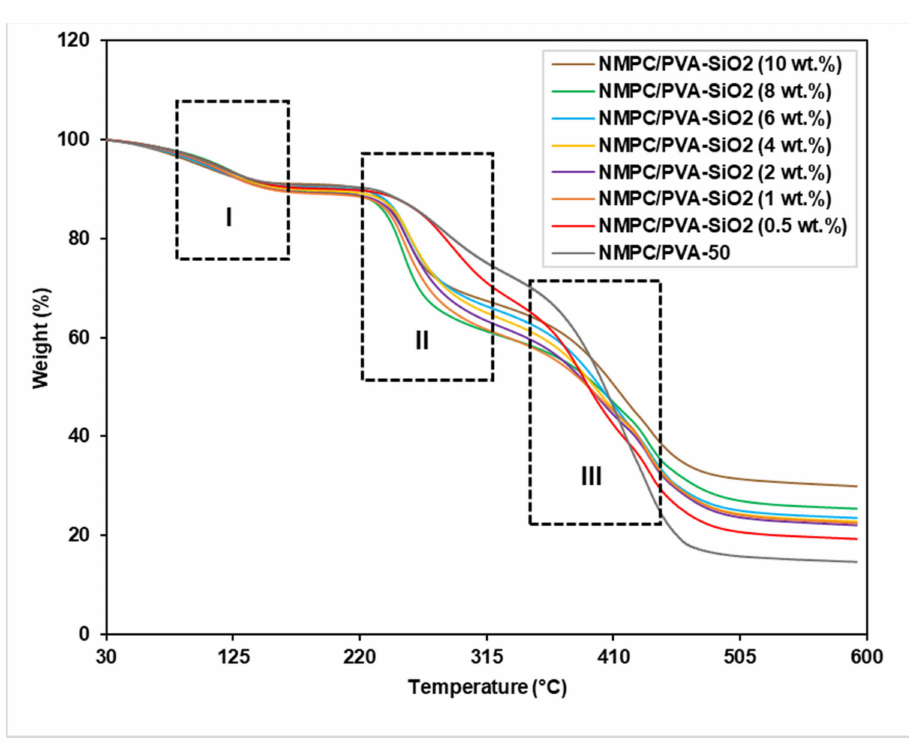
Figure 9. TGA curves of the NMPC/PVA-50 composite membrane and NMPC/PVA-SiO 2 composite membranes with different